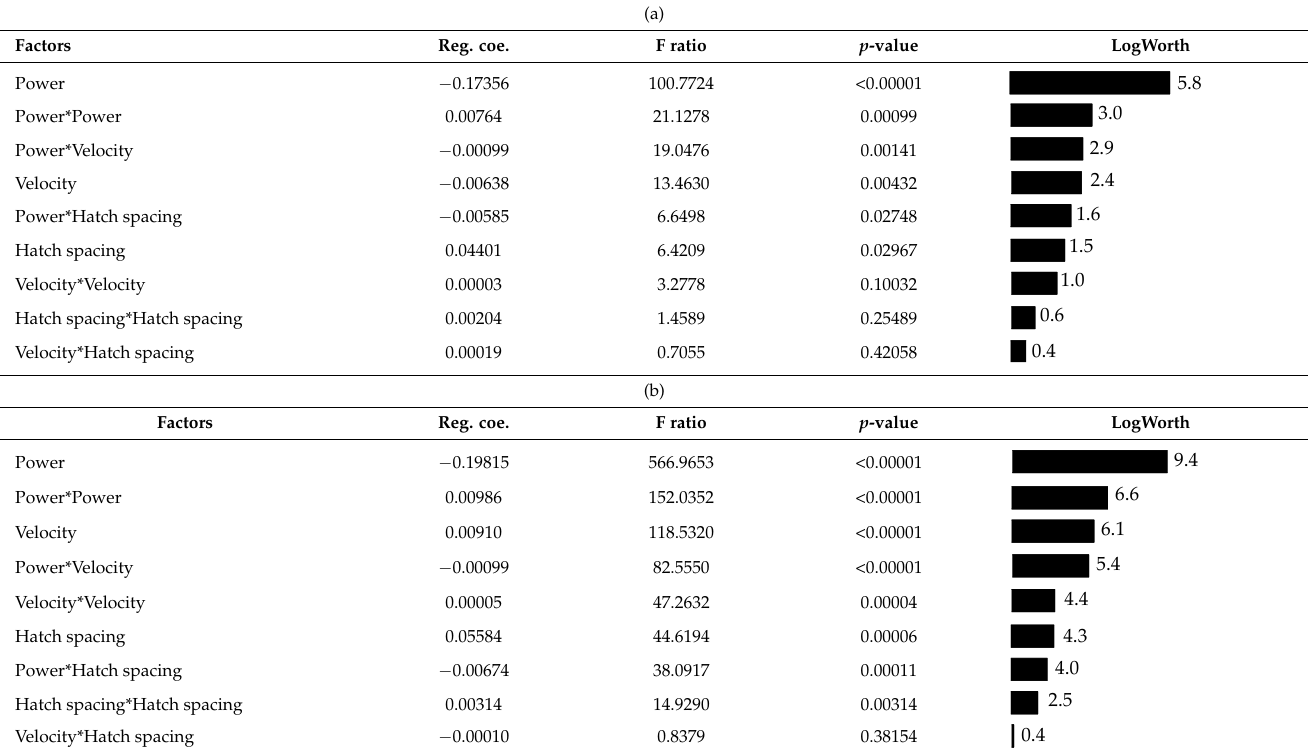
Table 3. Factors and their effect on porosity based on the regression model of (a) optical and (b) XCT data.